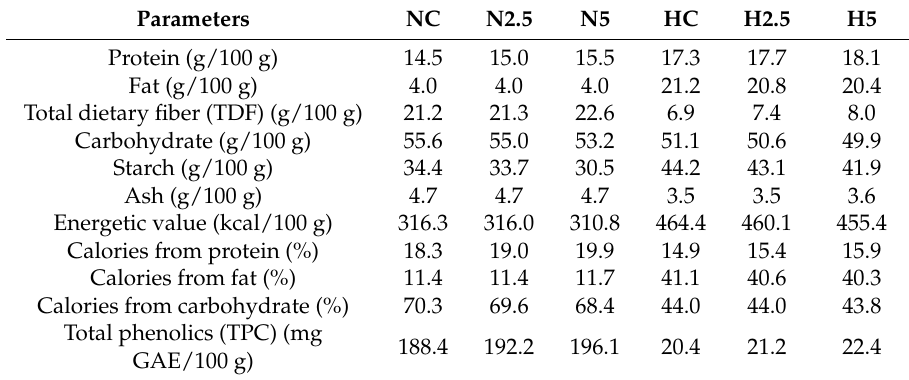
Table 1. Proximate composition, energy values and total phenolic compounds in the experimental diets 1 .